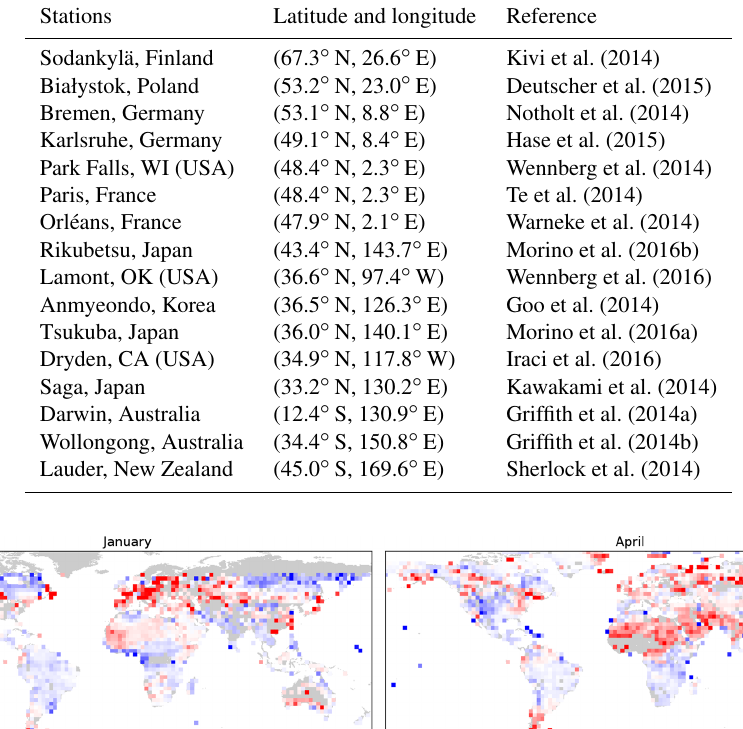
Table 4. List of TCCON stations used in the study.